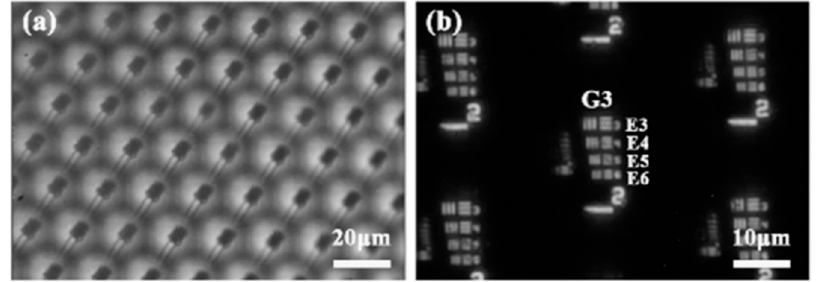
Figure 7. ( a ) Clear IR images obtained from the ChG MLAs; ( b ) IR images of a standard USAF1951 resolution target plate sampled by the MLA.